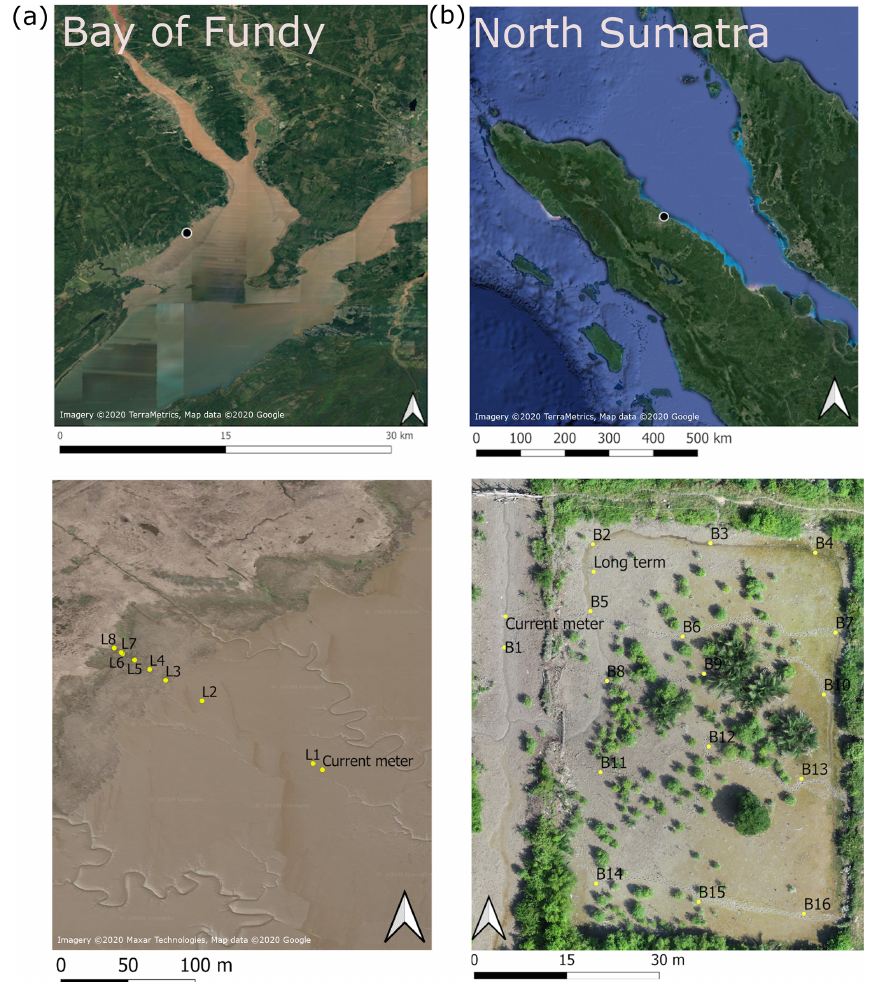
Figure 2. (a) The study sites in the Bay of Fundy, Canada, with eight Mini Buoys with a temperature and light sensor (see Fig. 1b) deployed along an elevational transect. L1 and L2 are located on the tidal flat, L3 is at the marsh edge, and L4–L8 are within the salt marsh (bottom left). (b) The short-term study site in Percut Sei Tuan, North Sumatra, Indonesia, with 16 Mini Buoys (B1–B16) deployed across an abandoned aquaculture pond that was naturally recolonized by mangrove plants (drone image on bottom right). Both study sites were equipped with a Nortek Aquadopp current meter close to L1 and B1 to calibrate the Mini Buoys. Maps were created using ©